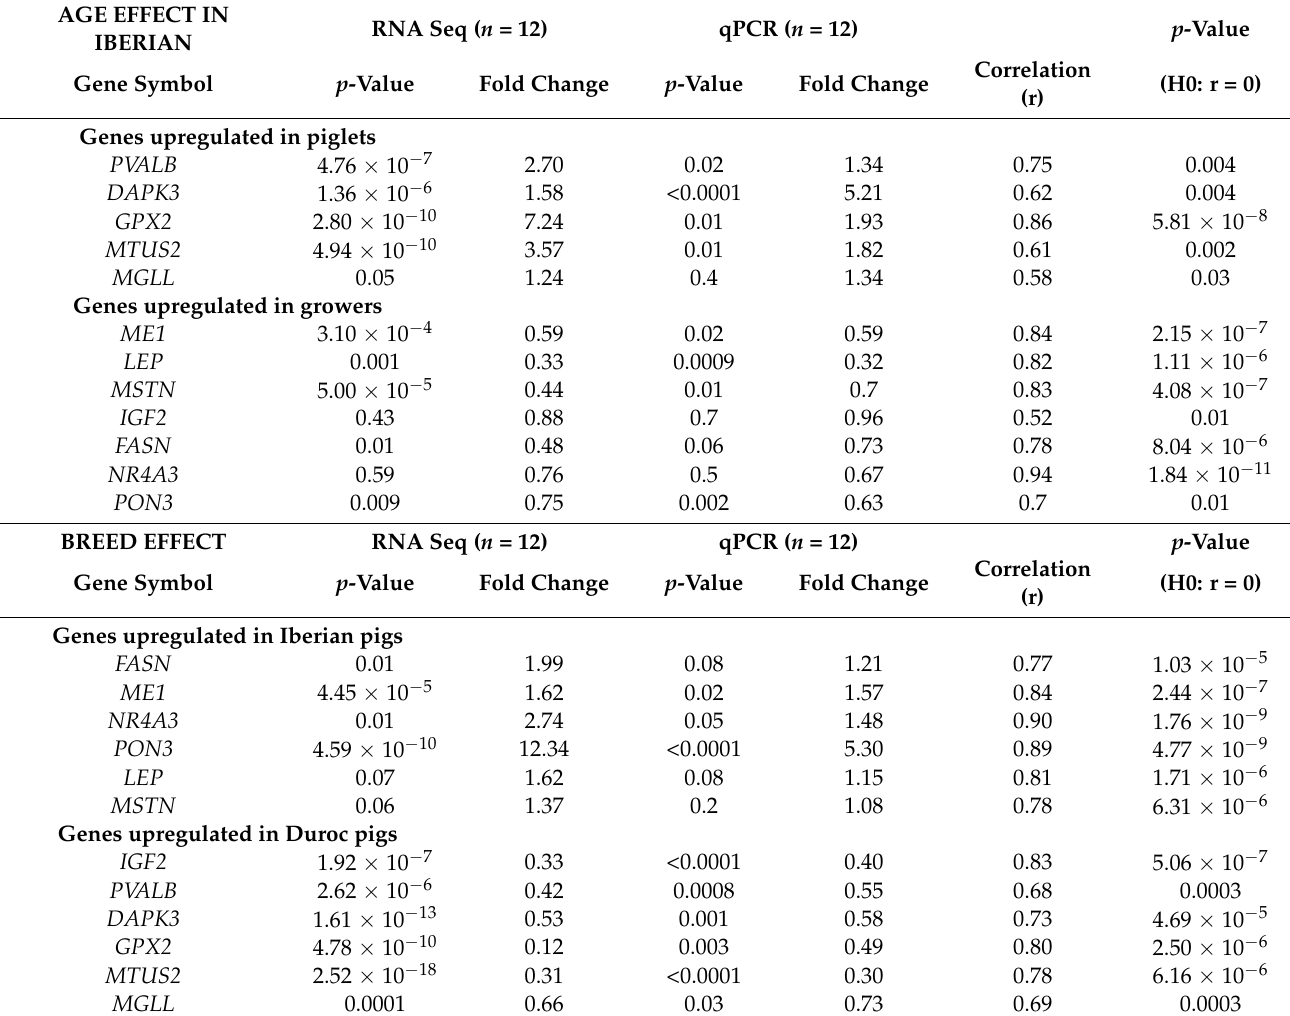
Table 8. Technical validation of RNA-seq results by quantitative PCR (qPCR): genes, statistical significance and fold change values (FC) obtained with both techniques for the breed and age effects, and Pearson correlation between expression values obtained from both